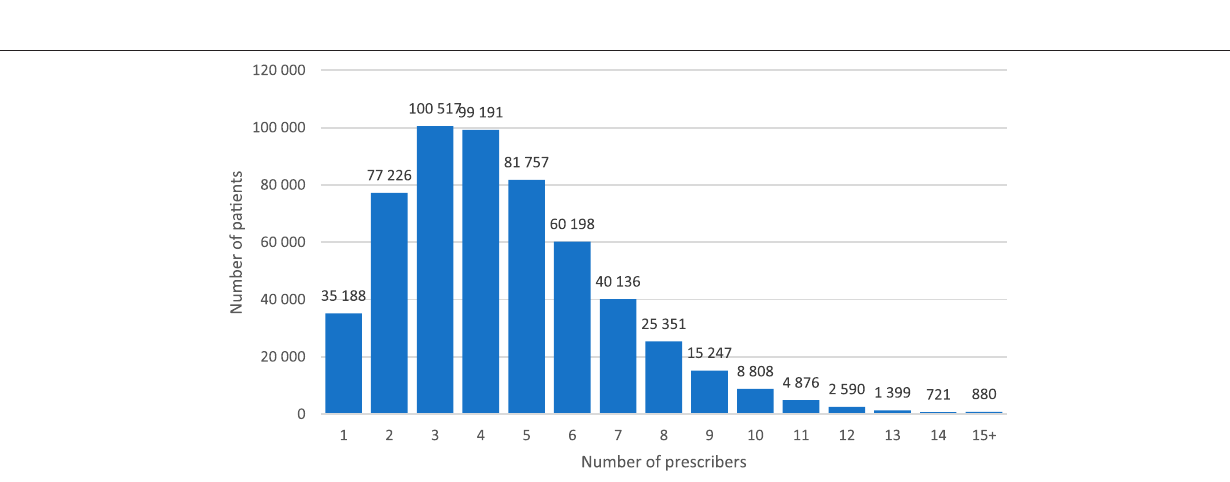
FIGURE 4 | Number of elderly patients on chronic polypharmacy in Poland in 2018 by number of prescribers who issued their prescriptions.